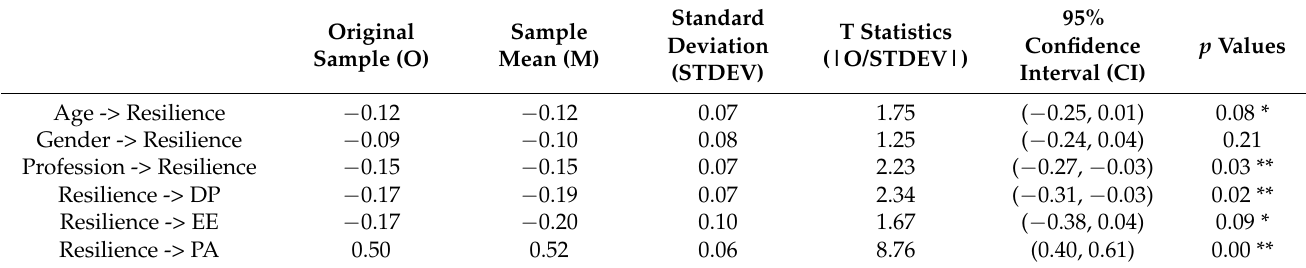
Table 4. Significance Testing Results of the Structural Model Standardized Path